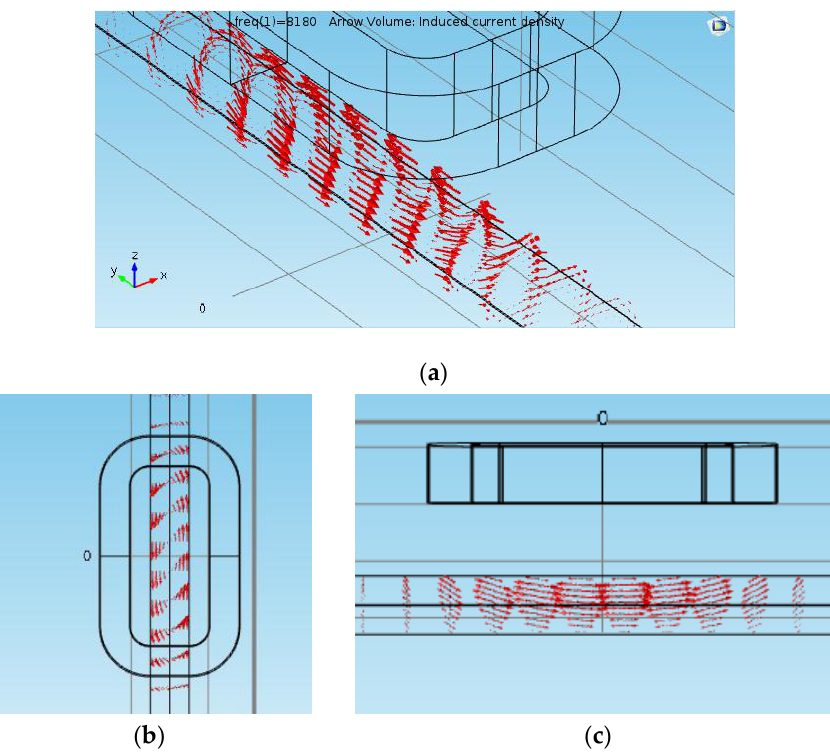
Figure 6. Induced current in the steel bar represented by the red arrows. ( a ) Perspective view; ( b ) Top view; ( c ) side view.